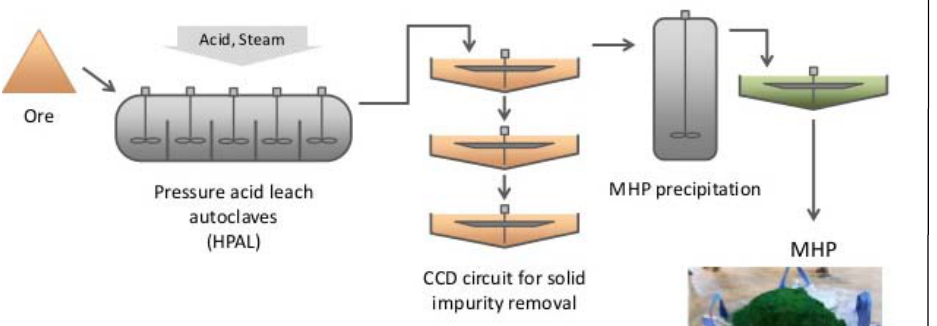
Figure 3 – Flowchart of the META Cobalt Nickel Process Рис . 3 – Схема META Cobalt Nickel Process Слика 3 – Шема за META Kobalt Nikal